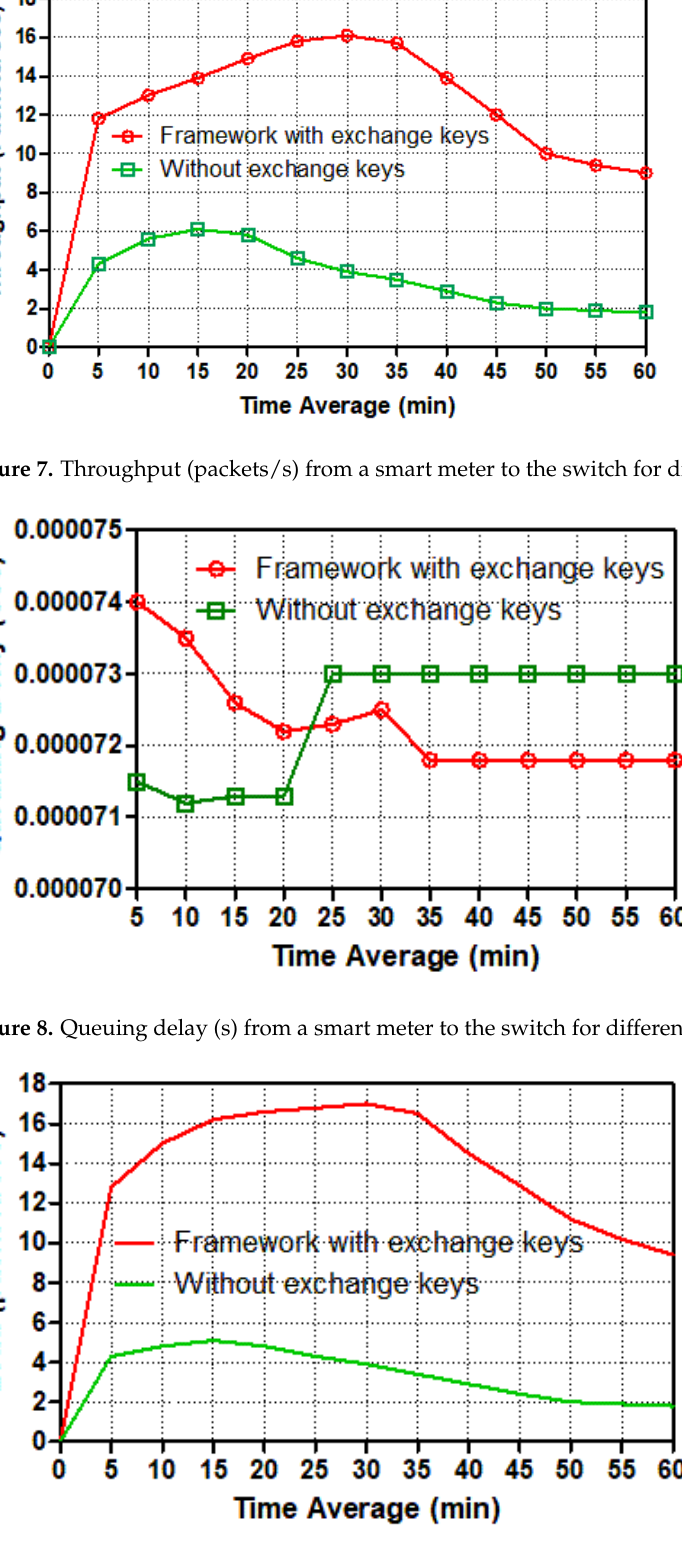
Figure 9. Load (packets/s) in a smart meter for different